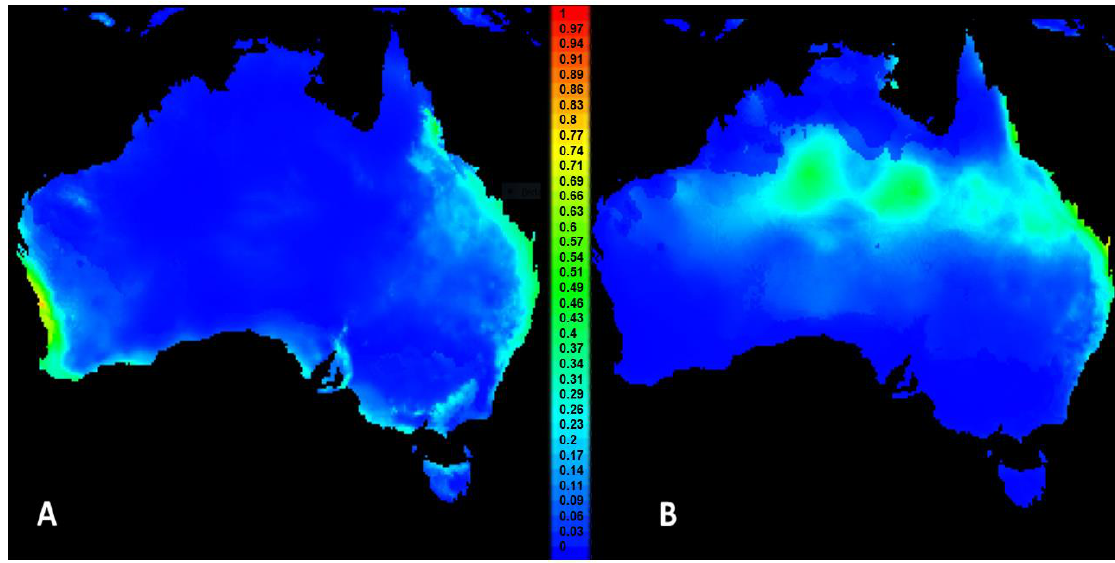
Figure 1. MaxEnt model predictions in Australia for Leptocybe spp. Lineage A ( A ) and Lineage B ( B ) based on their invasive global distributions. Colours illustrate climatic suitability (see scale in centre; 0 = lowest suitability and 1 = highest suitability).